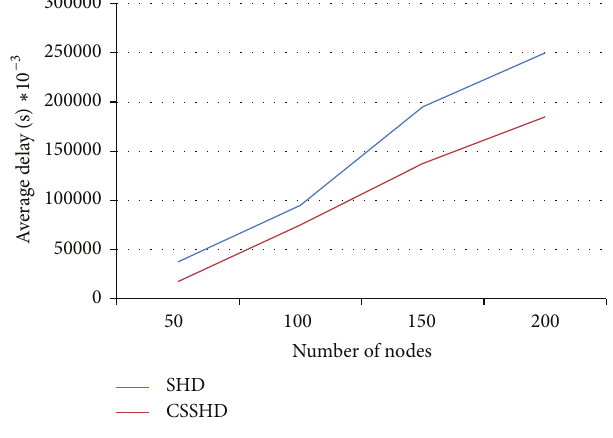
Figure 6: Graph for average